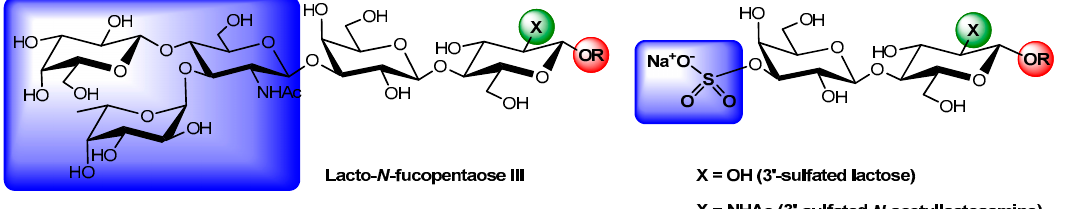
Figure 7. Comparison of structures of LNF-III ( left ) and 3 ′ -sulfated lactose derivatives ( right ) that bind almost equally well to human galectin-8N. Suggested additional modifications of the sugar head groups together with their substituents, which might increase the affinity of glycans toward galectins, while limiting synthetic efforts towards this achievement, are highlighted.